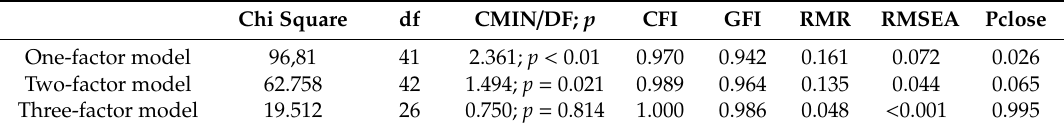
Table 1. Comparison of one-factor, two-factor, and three-factor models of attitude toward cryptocurrency.